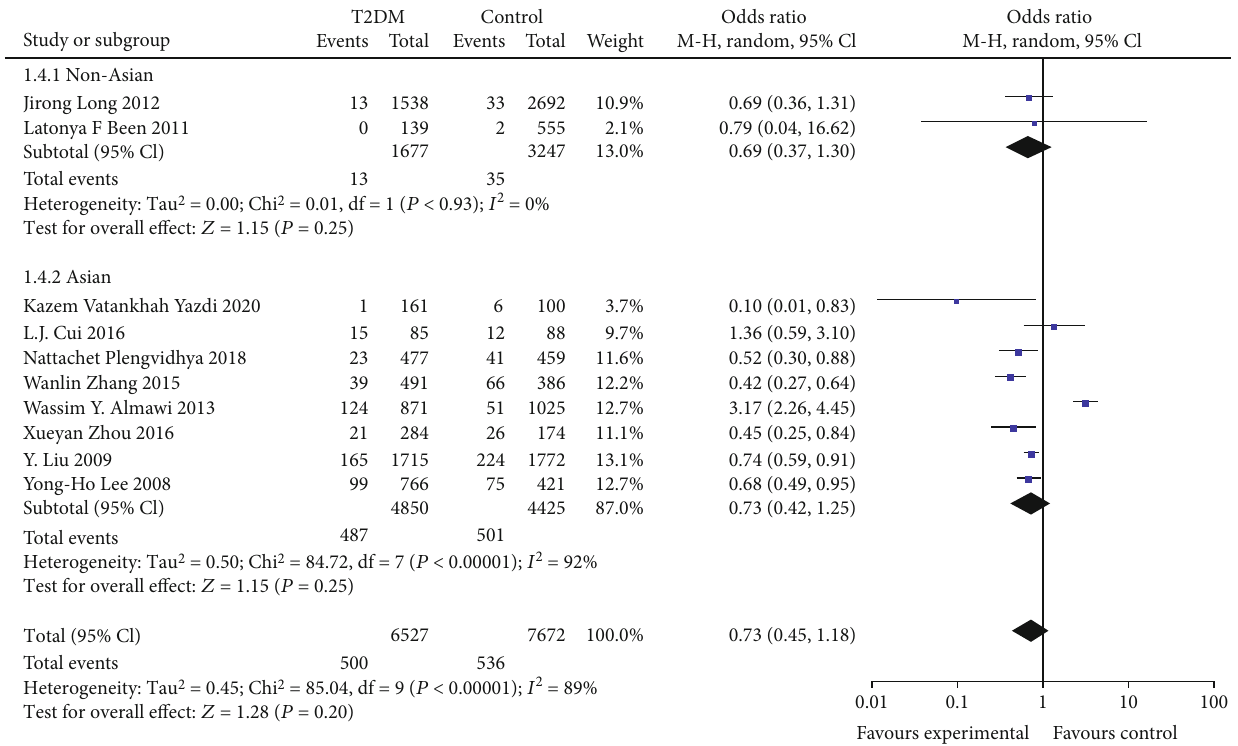
Study or subgroup